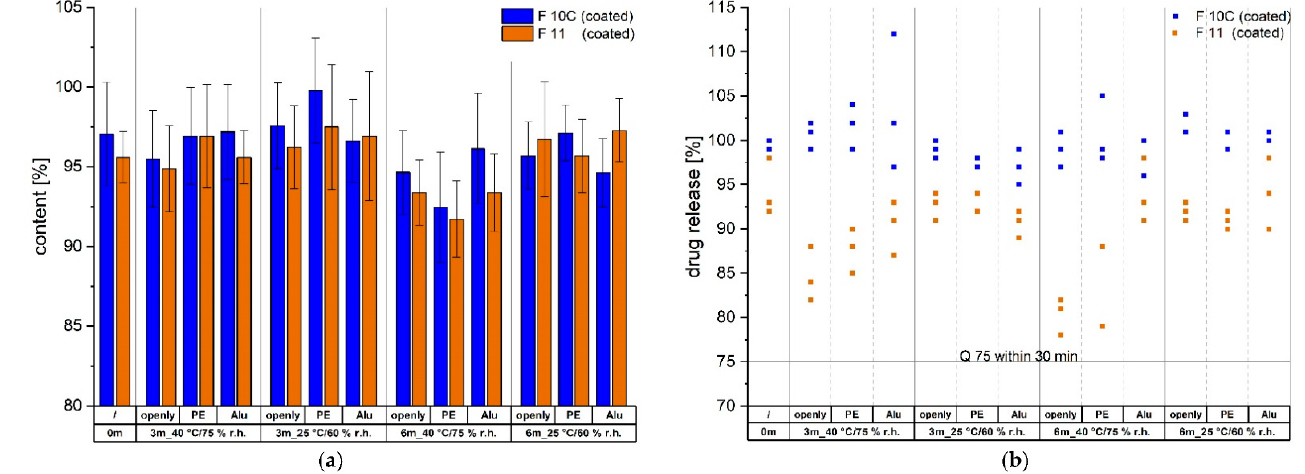
Figure 8. ( a ) Content (mean ± CI ( α = 0.05), n = 10) and ( b ) drug release in % at 30 min ( n = 3) of coated mini-tablets (F 10C and F11) stored at 40 °C/75% r.h. and 25 °C/60% r.h. in different packaging conditions (openly, in polyethylene bags (PE), and in sealed aluminium foil (Alu)). Selected timepoints: 0 months (0 m), 3 months (3 m), and 6 months (6 m) of storage.